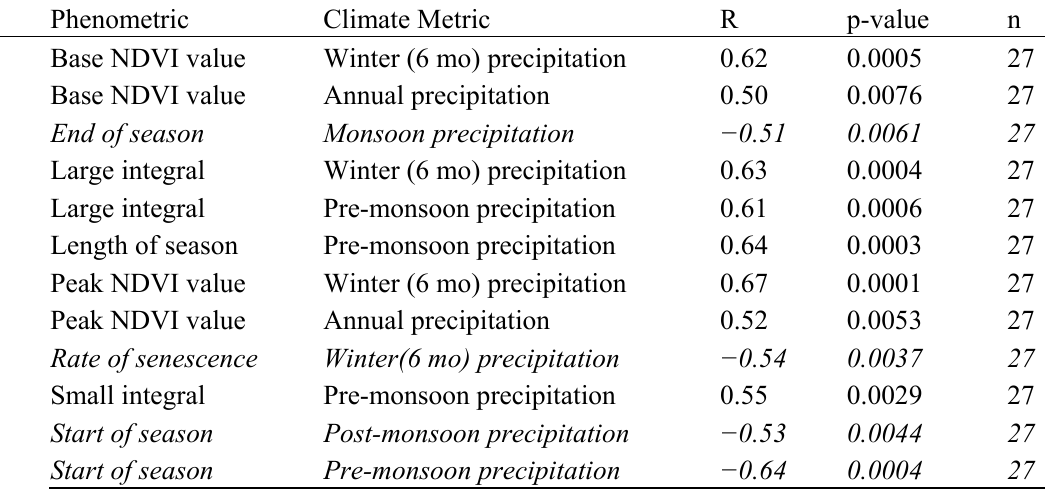
Table 3. Significant correlations (p ≤ 0.0081) between phenometrics and climate metrics for pine-oak woodland. Relationships that have negative R values are italicized. (Elevation ~2,204